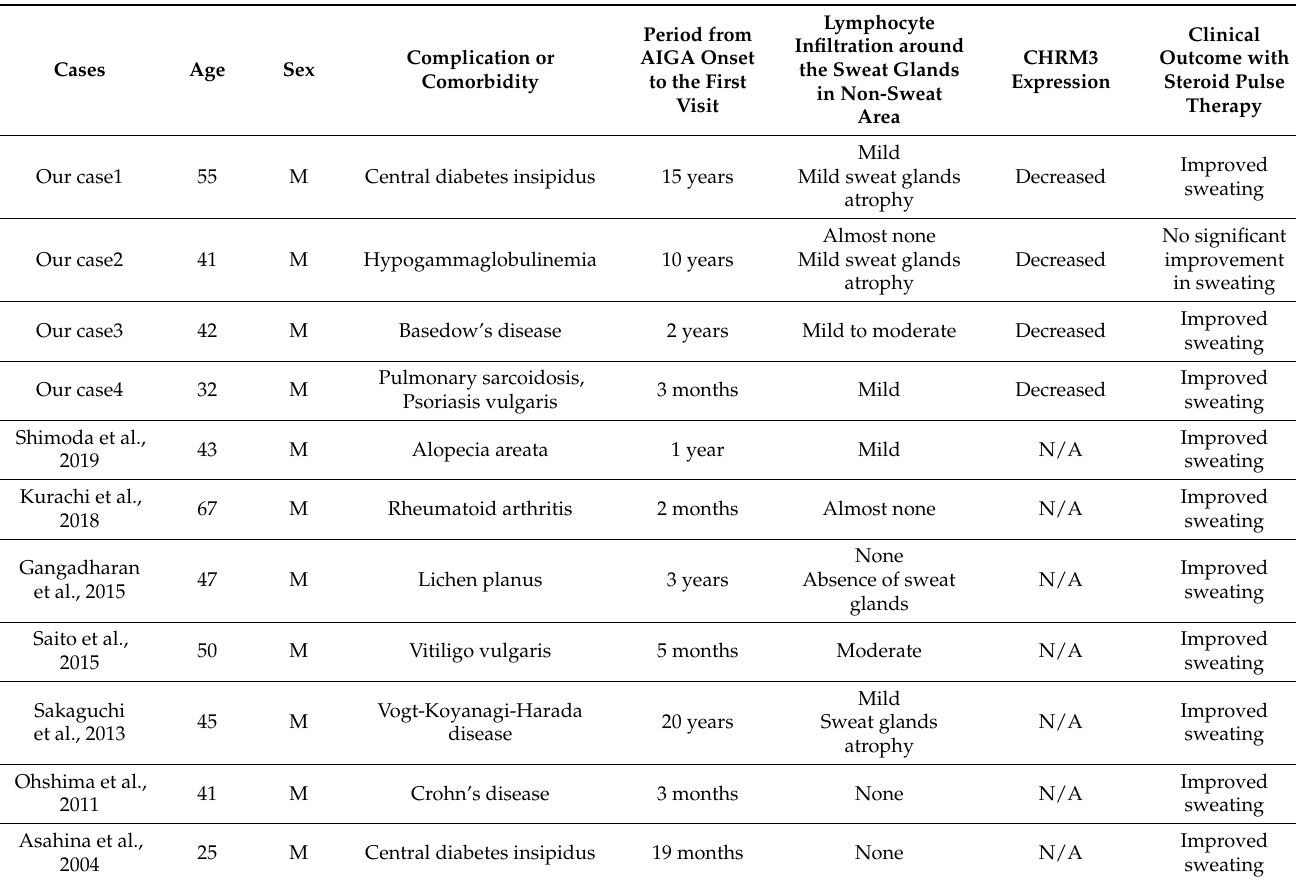
Table 1. Summary of our AIGA cases and other reported AIGA cases with complications or comorbidities that are considered to be autoimmune diseases or diseases with presumed autoimmune